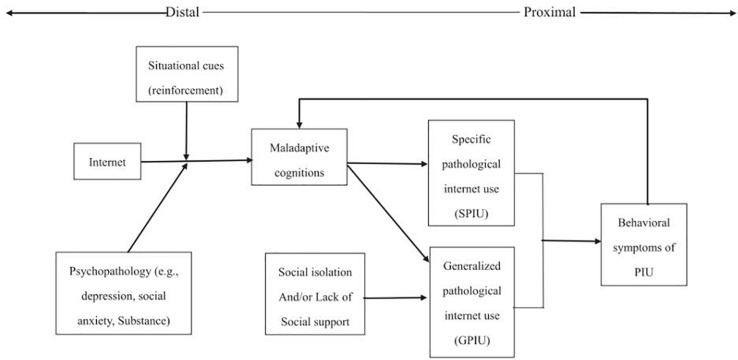
Cognitive behavioral model of pathological internet use (PIU). Adapted from Davis (2001).